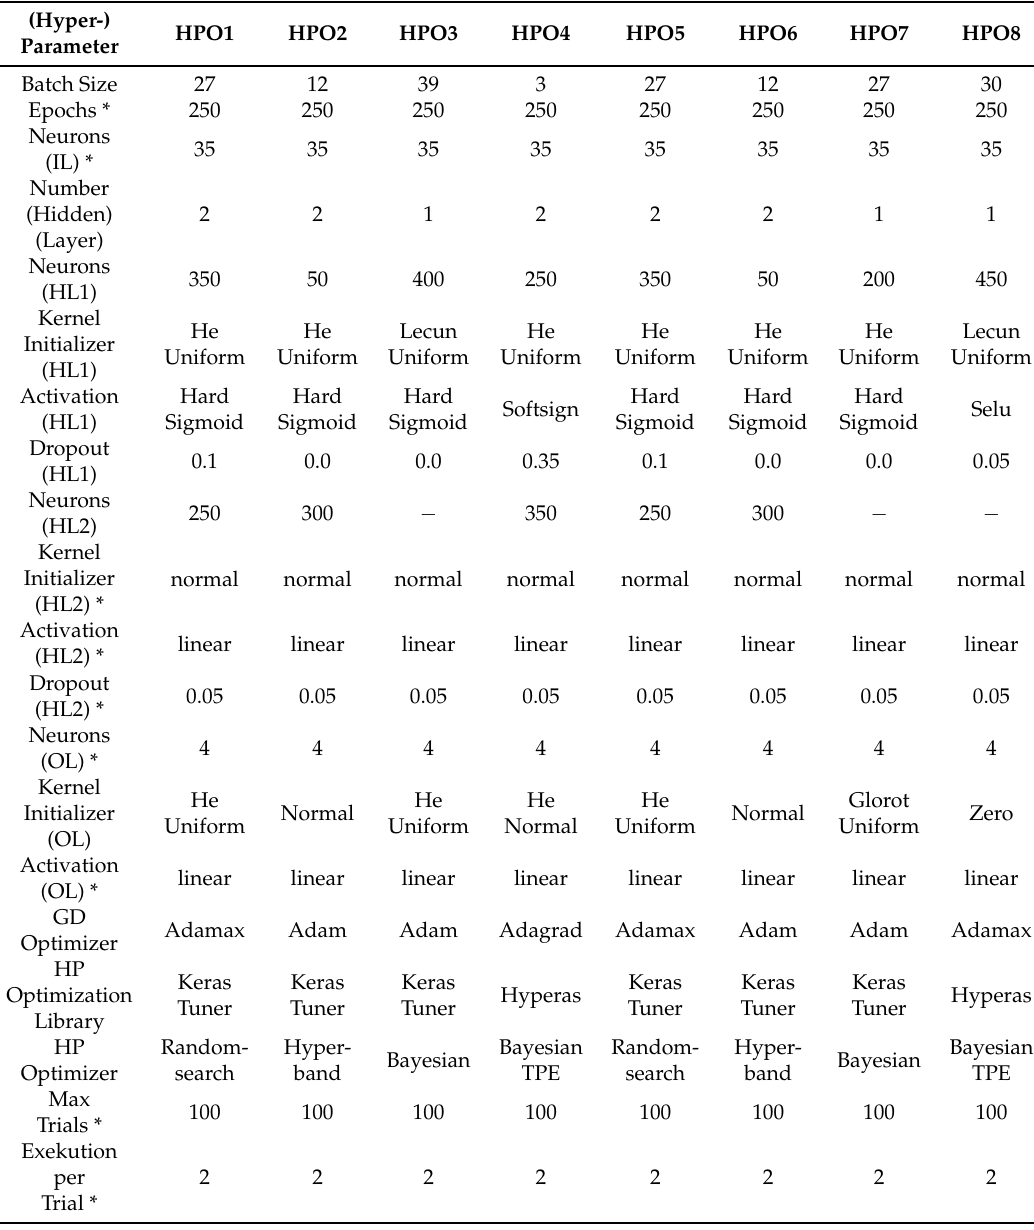
Table A7. Neural net settings from hyperparameteroptimization (* = default